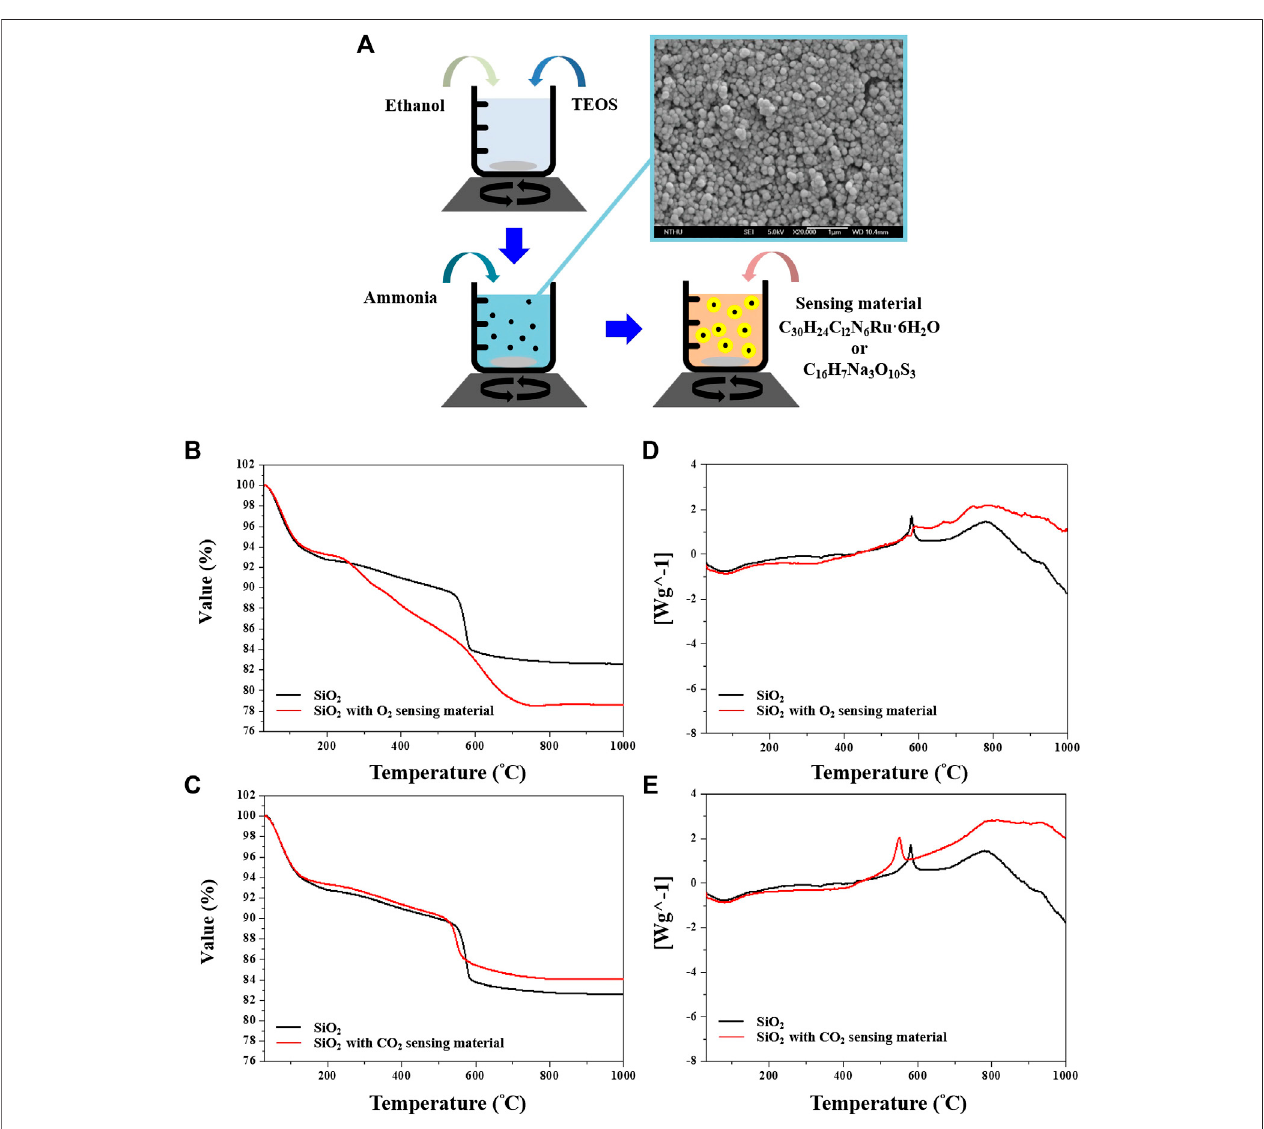
FIGURE 6 | Fabrication and characterization of sensing materials: (A) sensing fi lm fabrication process steps and SEM micrographs of sol-gel/silica, (B,C) TGA thermogram results, respectively, for O 2 and CO 2 sensing materials with silica, and (D,E) DSC thermogram results, respectively, for O 2 and CO 2 sensing materials with